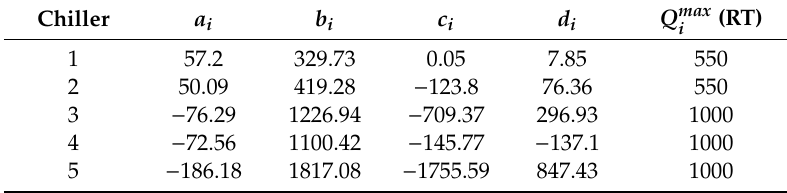
Table 1. Power consumption coefficients and cooling capacity of chillers.